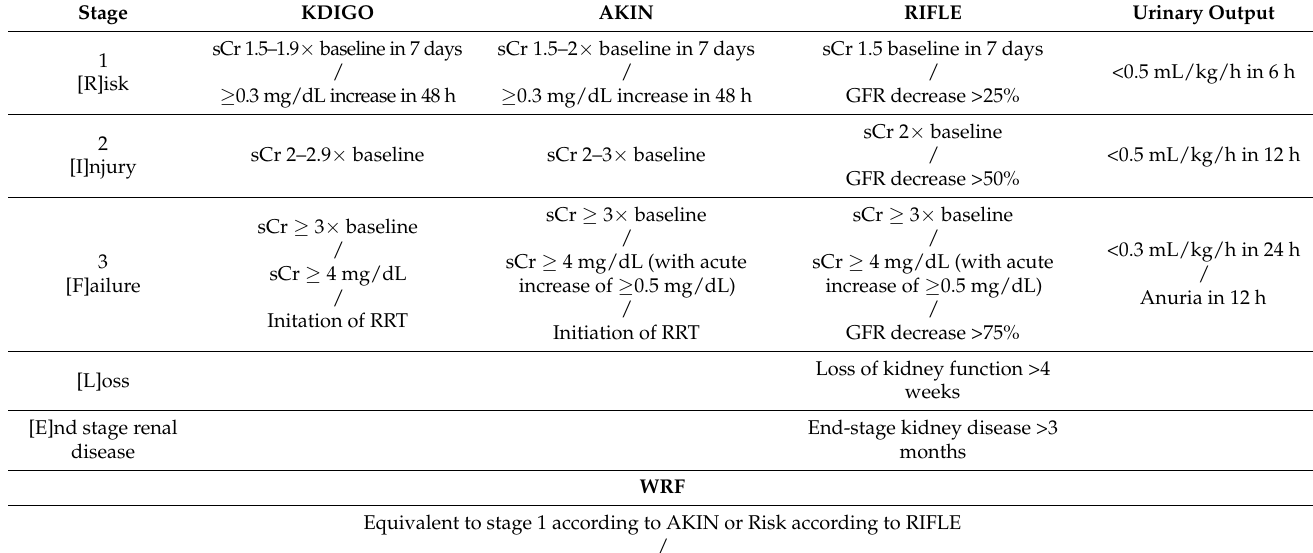
Table 2. Definitions of acute kidney